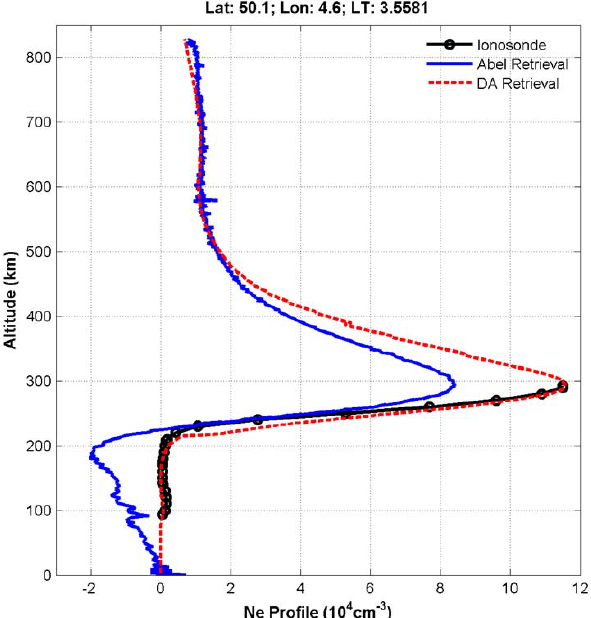
Fig. 37. An example of profiles of Abel and data assimilation re- trievals of electron density (Ne in 10 4 cm − 3 ) compared to a co- located Ionosonde-observed electron density profile (Yue et al., 2011).